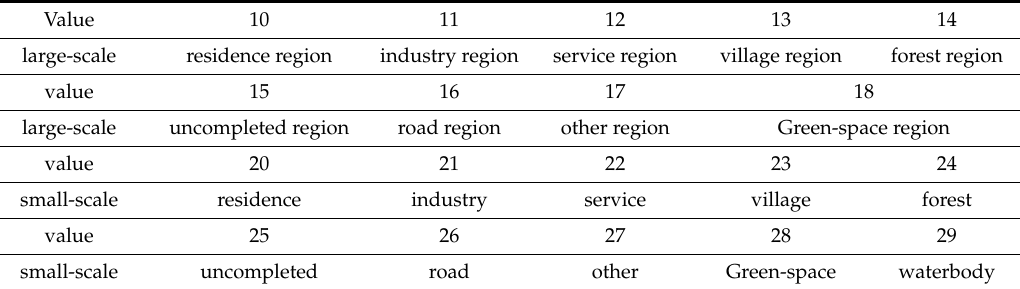
Figure 1. Multi-spatial scale semantic segmentation and image caption. It shows a two-scale hierarchy of one image. An image contains many large-scale objects, each large-scale object contains many small-scale objects, and there are spatial relationships between objects of the same scale. Our strategy of captioning is to describe both information of scale and spatial relationship contained in an image as completely as possible. Table 1. Classification of multiscale remote sensing objects.